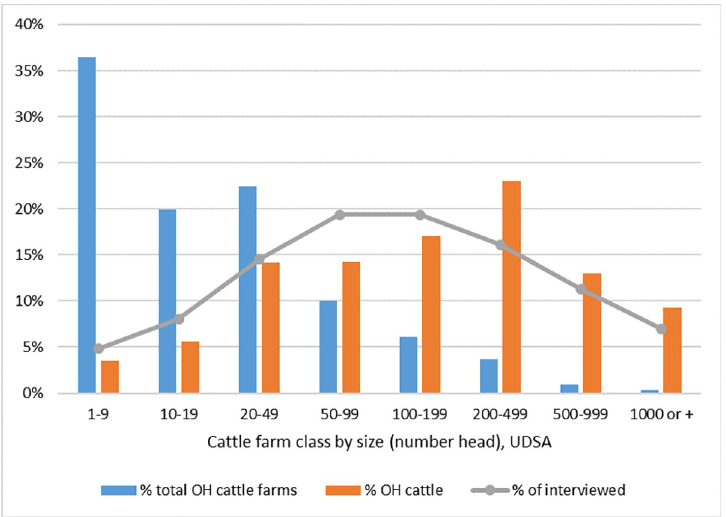
Fig 1. Size distribution of Ohio cattle farms interviewed for this study. Percent interviewed as compared to percentage of OH farms by USDA size class and percentage of animals (number head).